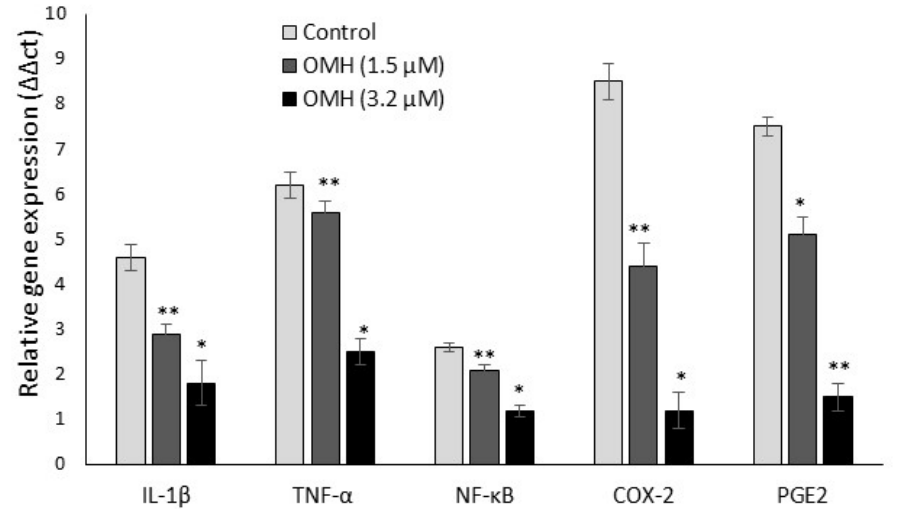
Figure 3. Effect of OMH on proinflammatory and protumorigenic gene expression levels in HT-115 cells after 48 h. Data presented as the means ± SD ( n = 6). Values sharing a common superscript as * p ≤ 0.01 and ** p ≤ 0.05 compared with untreated HT-115 cells.